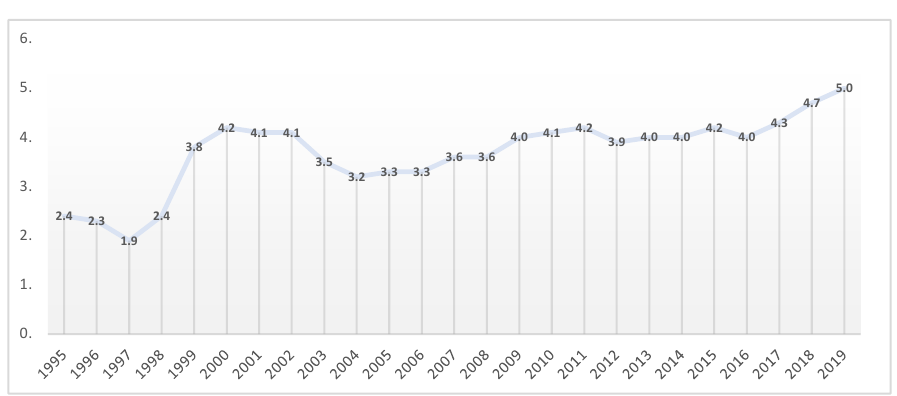
Figure 2. Current health expenditure (% of GDP) in Romania. Source: computed by authors using the Eurostat database [23].